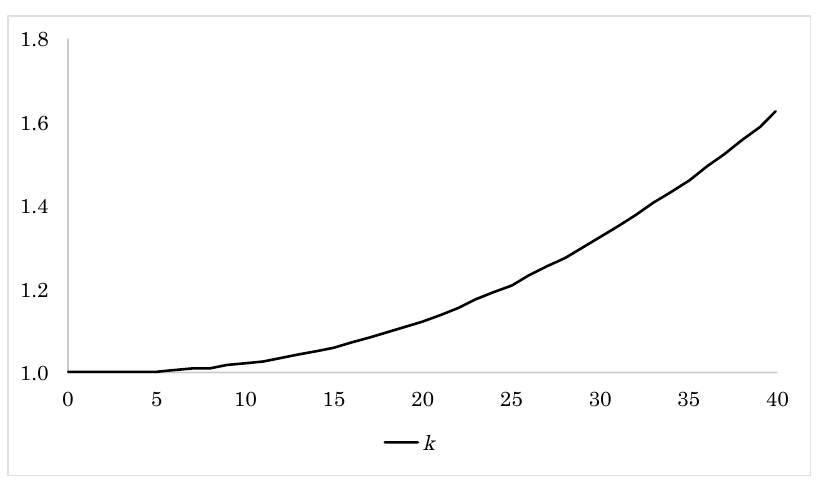
Figure 2. Approximated expected upscaling factor k as a function of time.